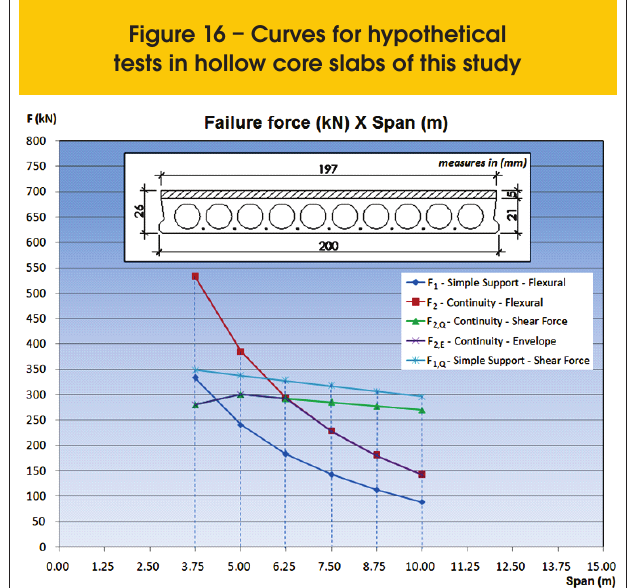
Figure 16 – Curves for hypothetical tests in hollow core slabs of this study